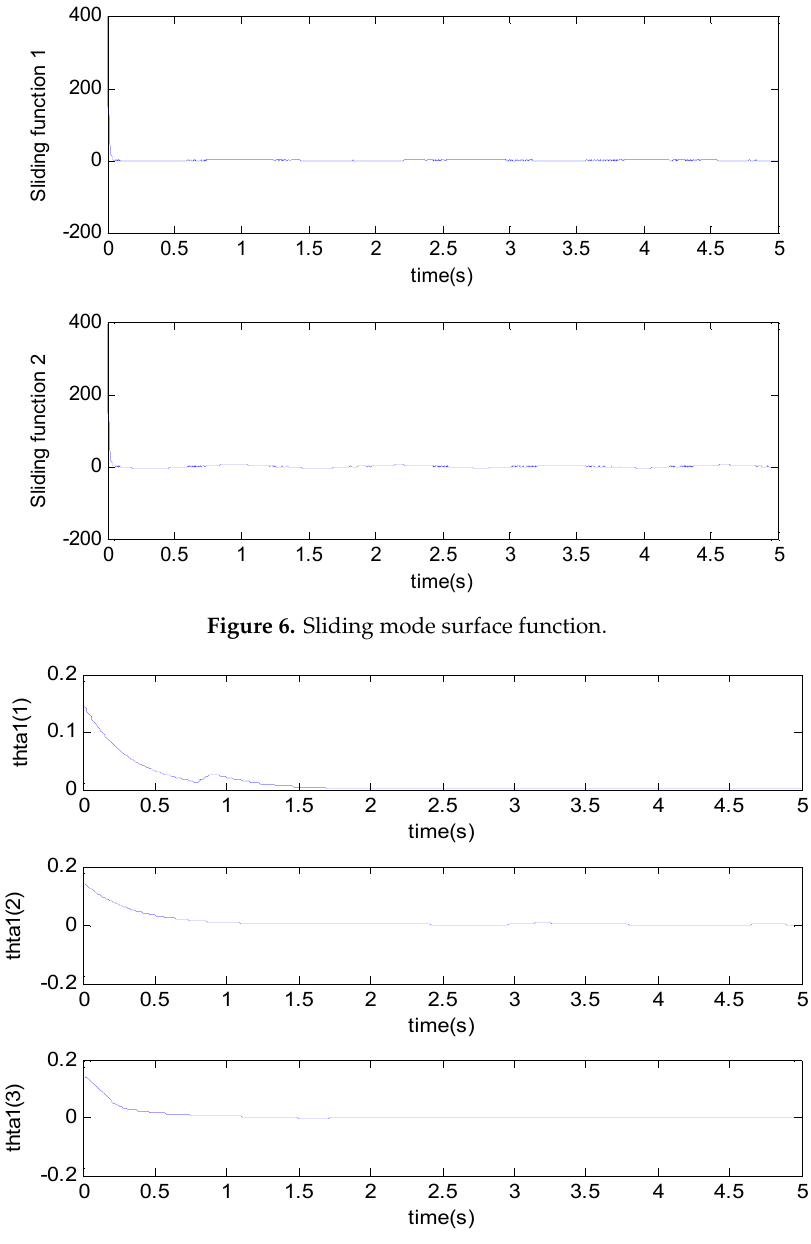
Figure 7. The first parameter using the ABFSMC approach.